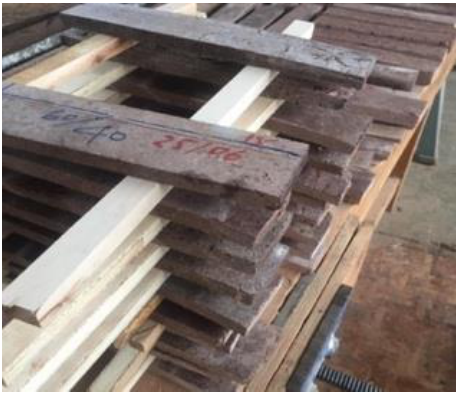
Figure 5. Particleboard storage.